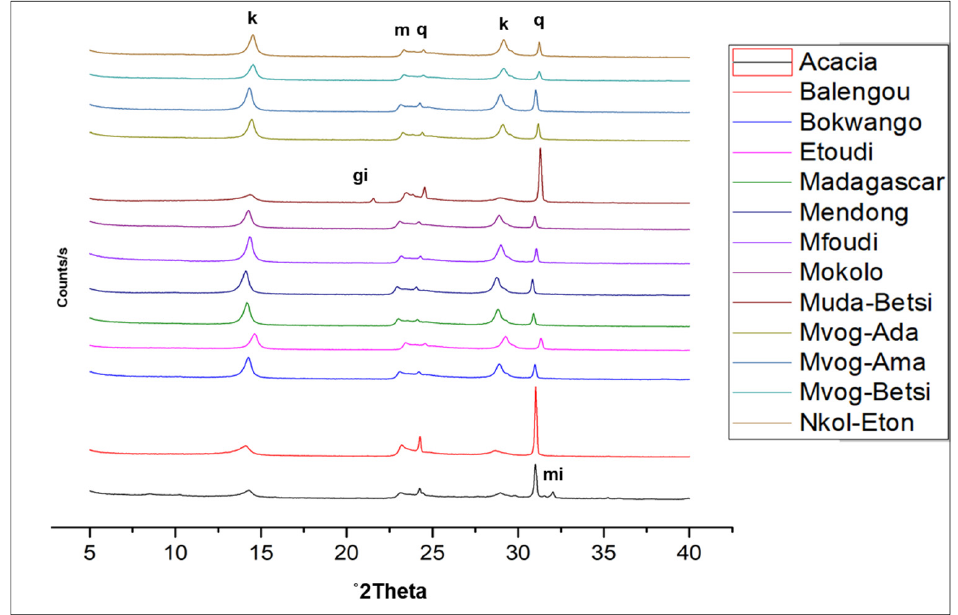
Figure 2. X-ray diffractograms of the studied geophagic clays from the various markets with the highest kaolinite contents showing kaolinite (k), quartz (q), muscovite (m), gibbsite (gi) and microcline (mi).